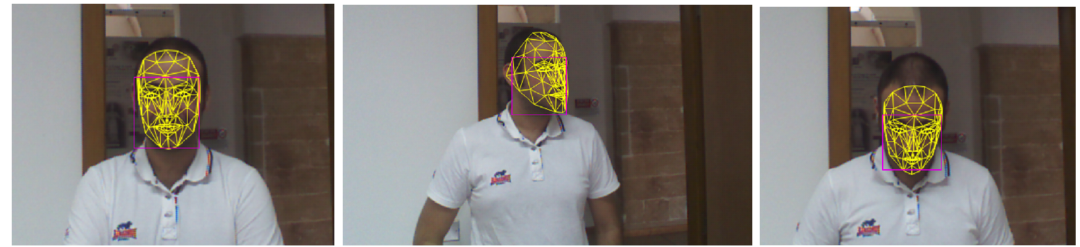
Figure 2. Three different snapshots of the face tracking